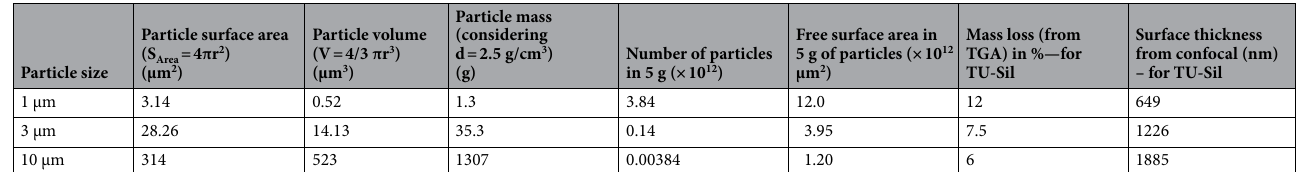
Table 3. Surface area (µm 2 ), volume (µm 3 ), and mass (g) for each size of the particles, considering the filler particle density 2.5 g/cm 3 and the shape being a sphere. The mass was randomly fixed as 5 g, since the aim was to highlight differences in free surface area of the particles subjected to the functionalization